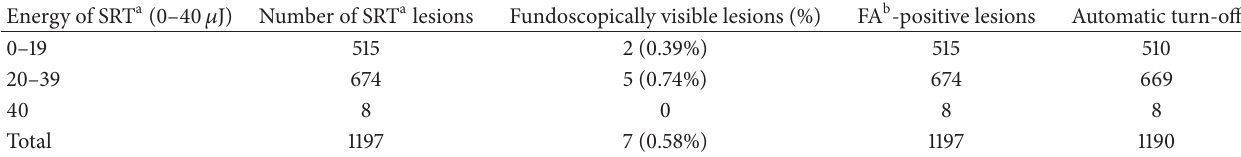
Table 1: The results of automatic turn-off in the selective retina therapy groups.